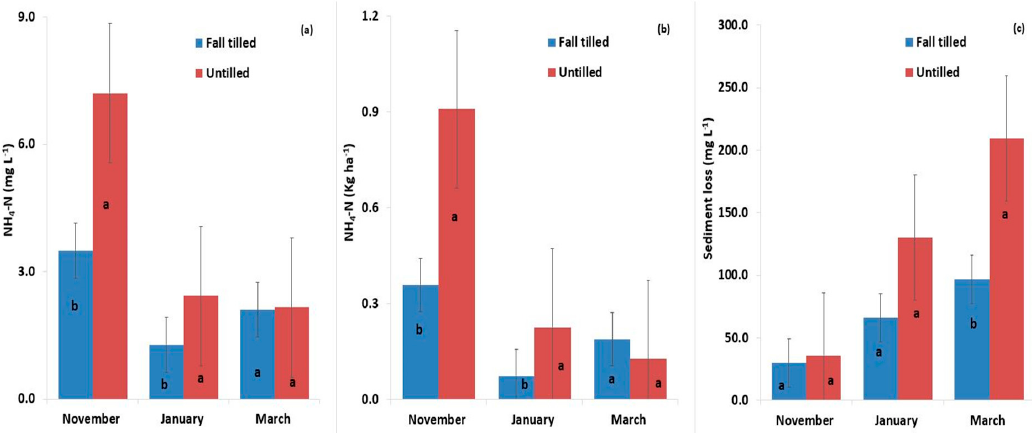
Figure 8. Significant interaction of tillage and manure timing treatment on ( a ) ammonium nitrogen (NH 4 -N) concentration, ( b ) ammonium nitrogen (NH 4 -N) load, and ( c ) total suspended solids concentration in snowmelt runoff; Brookings, SD. Different letters indicate significant interactions between concentrations and loads due to treatments. The bars indicate standard errors.